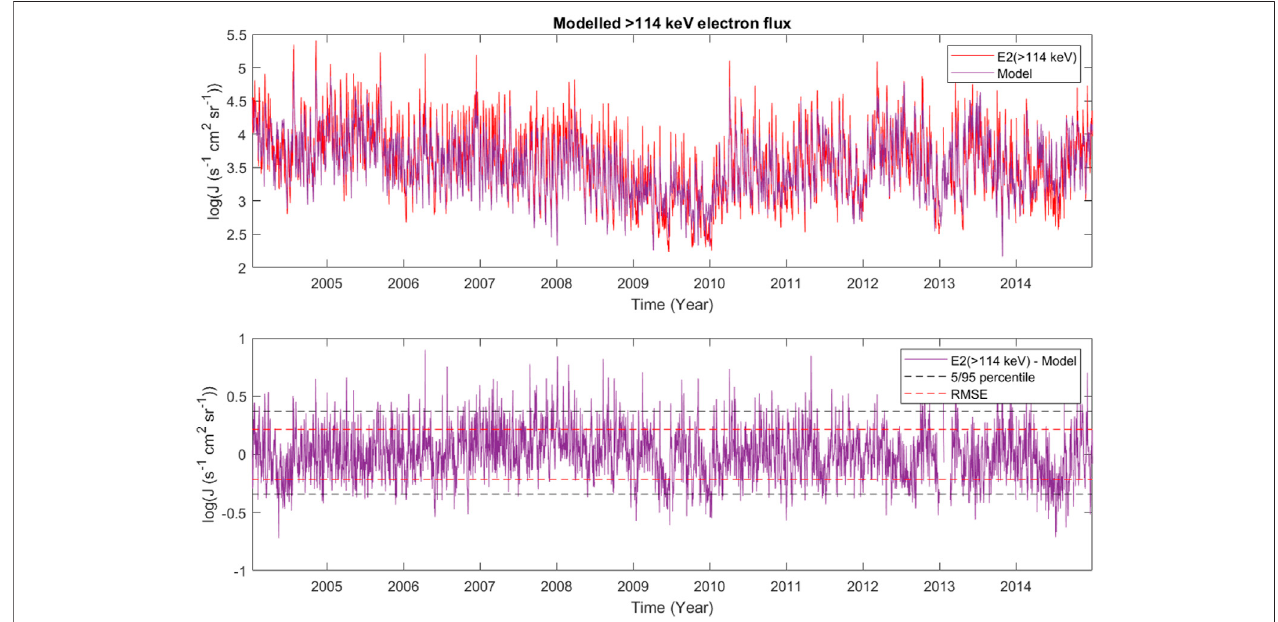
FIGURE 8 | The upper panel shows the observed (red) and modelled (purple) daily resolved fl uxes > 114 keV in the period from 2004 to 2014. The lower panel shows the difference between the observed and modelled fl uxes.